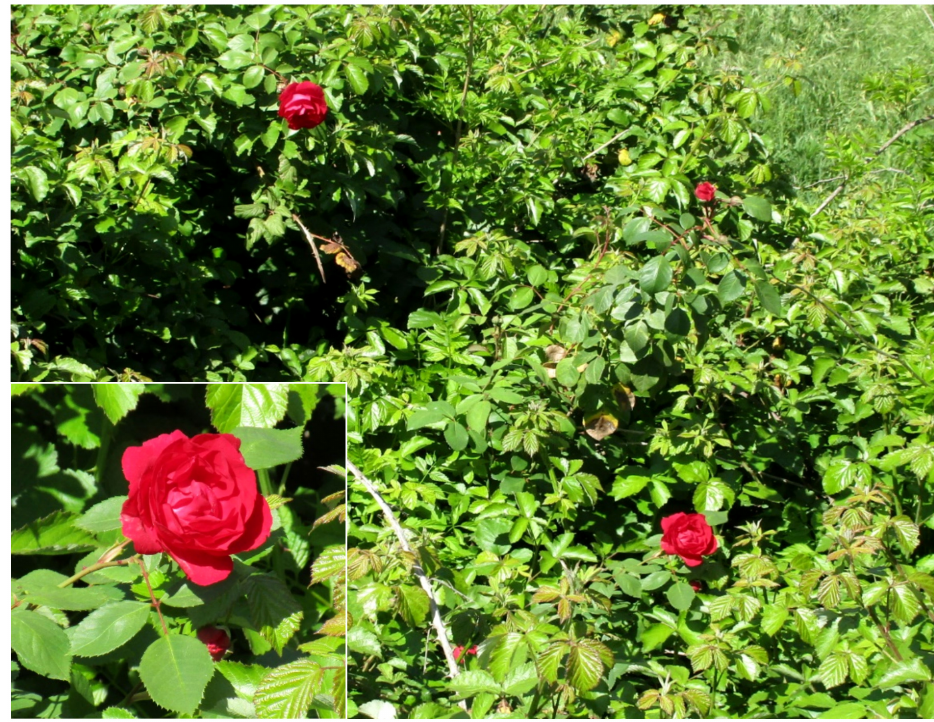
Figure 46. Rosa chinensis var. semperflorens in Caffarella valley.